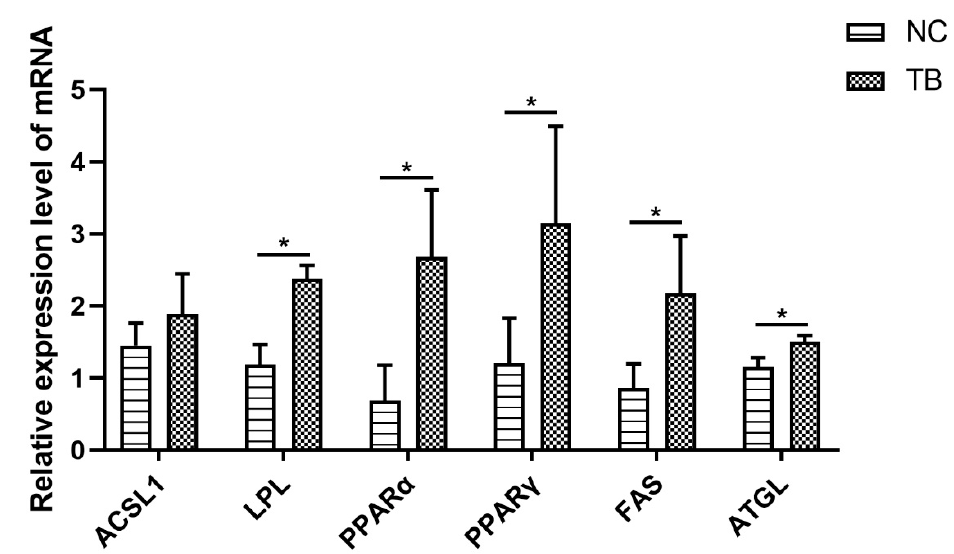
Figure 2. TB improved the lipid metabolism in the liver. Values are expressed as the mean ± SE ( n = 4). * indicates significant difference ( p < 0.05).